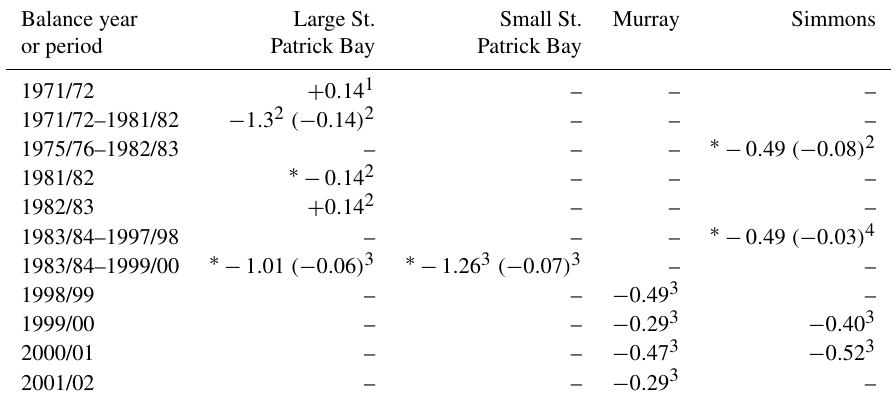
Table 1. Directly measured mass balances (meter water equivalent) of the Hazen Plateau ice caps. Where a value represents a multiyear record, the average annual value is shown in parentheses. Asterisks denote minimum estimates.